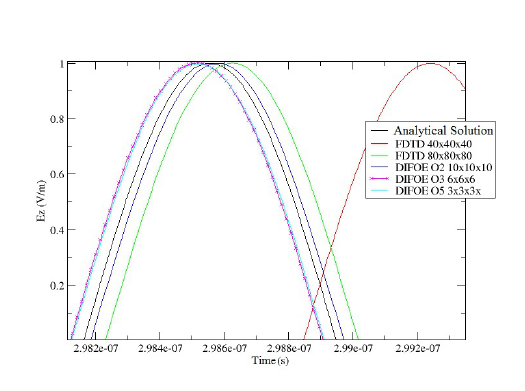
FIGURE 8: TE 3 , 3 , 0 cavity mode inside a 1 m perfectly metallic cube. Plots labelled "DIFOE" are results obtained with the FEM method with various spatial orders (2, 3